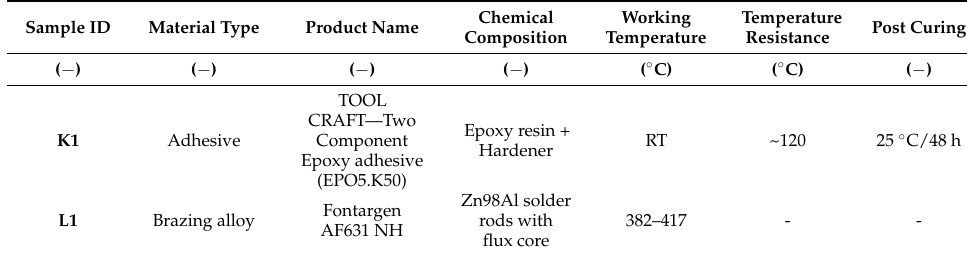
Table 2. Properties of brazing alloy L1 and adhesive paste K1.